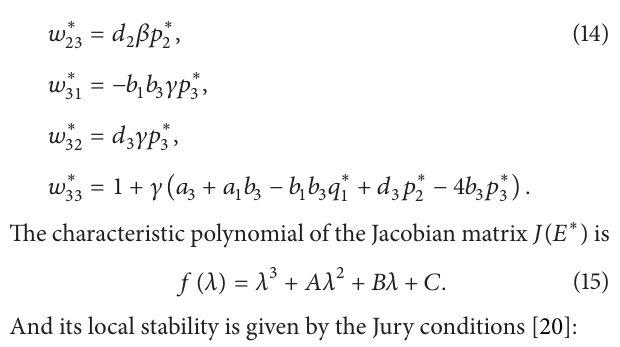
Figure 1: The stable region of the Nash equilibrium point 𝐸 ∗